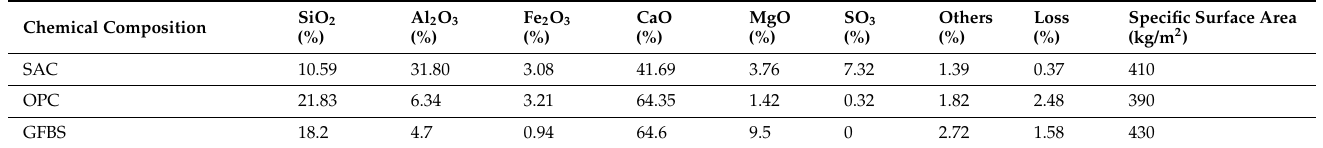
Table 1. Chemical and physical properties of different cementitious composite materials.